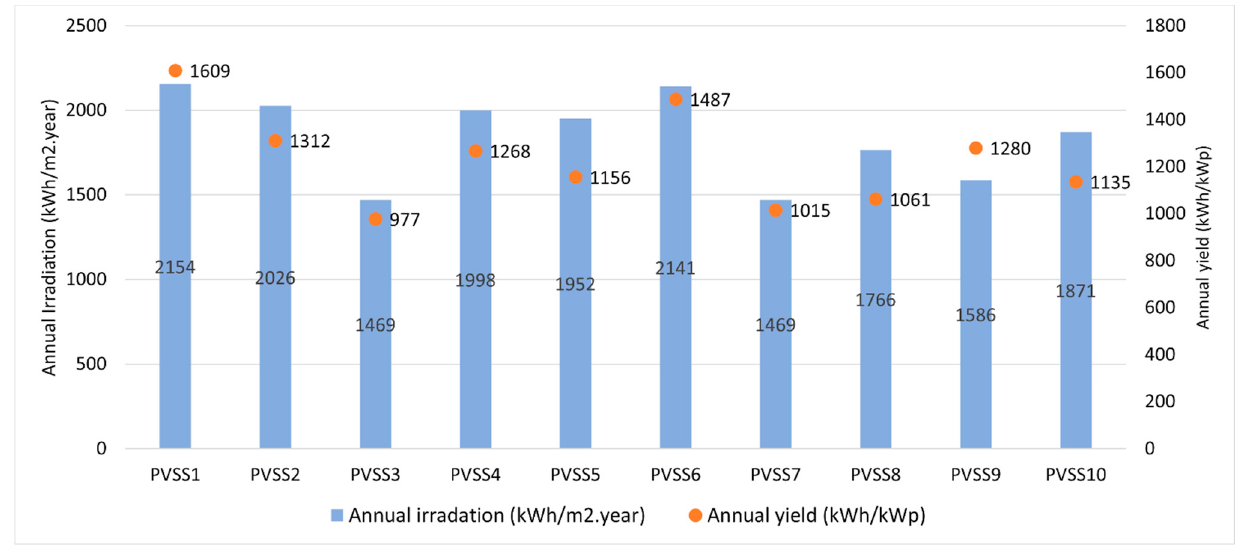
Figure 11 . Comparison of annual irradiation with PV electricity generation. Figure 11. Comparison of annual irradiation with PV electricity